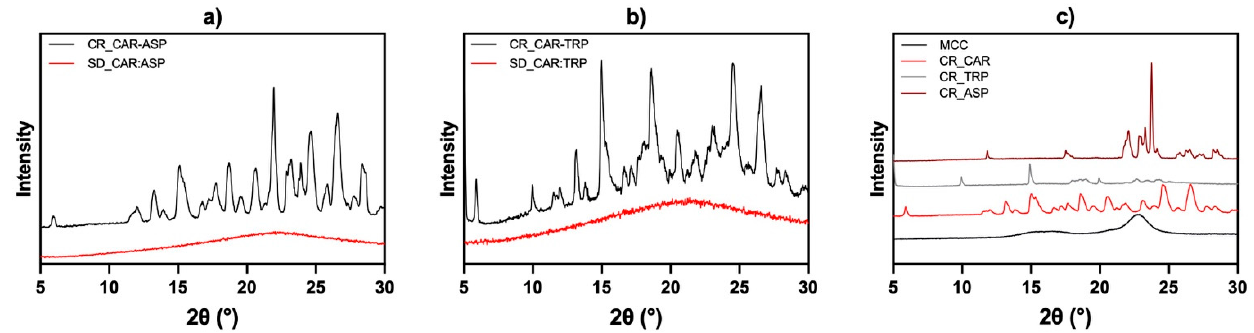
Figure 1. XRPD of physical mixture (CR) and spray-dried system (SD) of ( a ) CAR:ASP and ( b ) CAR:TRP, and ( c ) XRPD of crystalline MCC, CAR, TRP, and ASP.